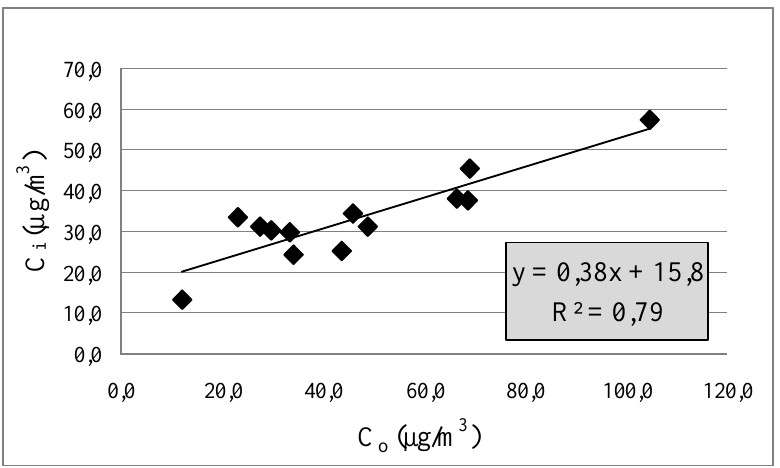
) for every school building during both i